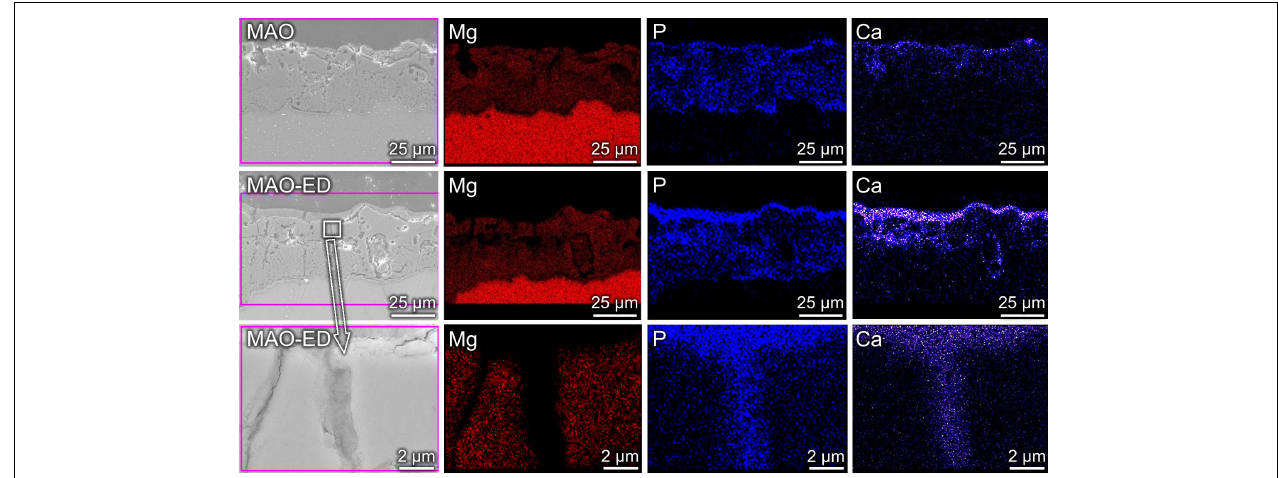
FIGURE 2 | Element distributions of MAO coating and MAO-ED coating.